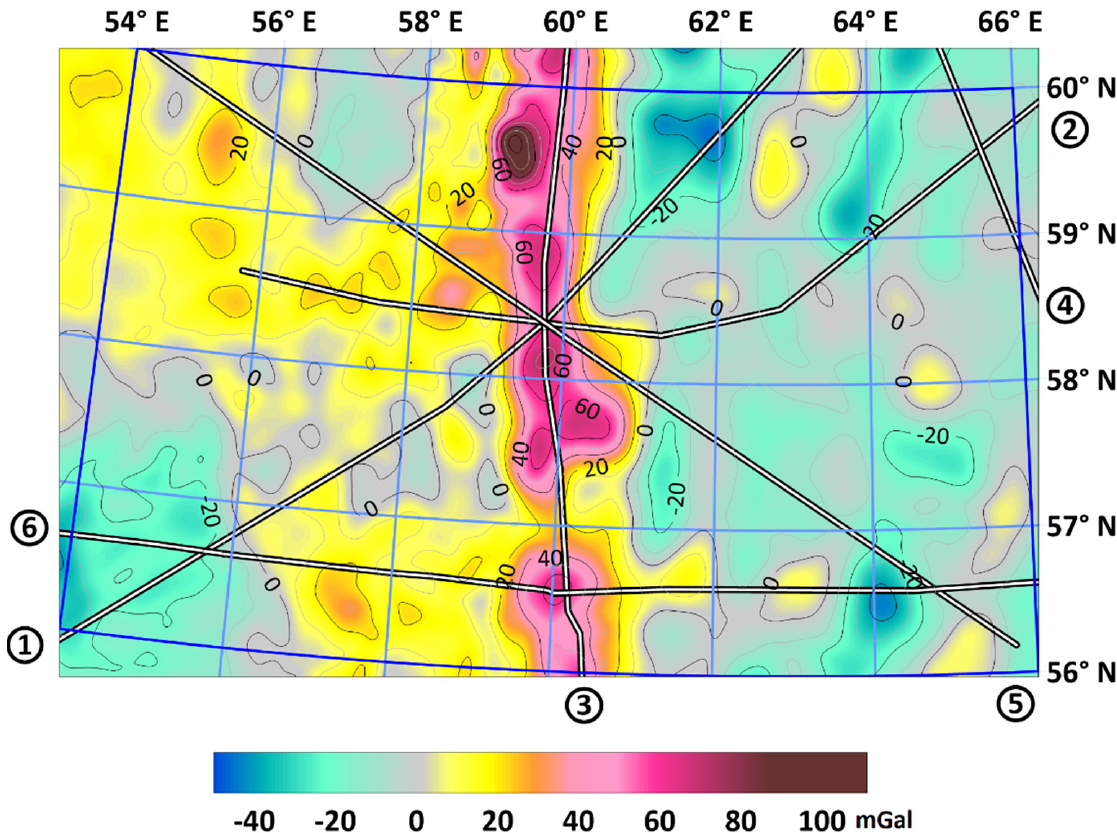
Figure 1. DSS profiles scheme with a map of a gravity field anomaly (XGM2019e_2159) in the Bouguer reduction. (1) Granit + Rubin-2; (2) Krasnouralskiy + Khanty-Mansiyskiy; (3) VNTO; (4) N. Sosva–Yalutorovsk; and (5) Rubin-1; (6) Sverdlovskiy. The initial density model frame is formed with the 2D density cuts along the regional profiles (Figure 2). The data between profiles are interpolated values (layer by layer)